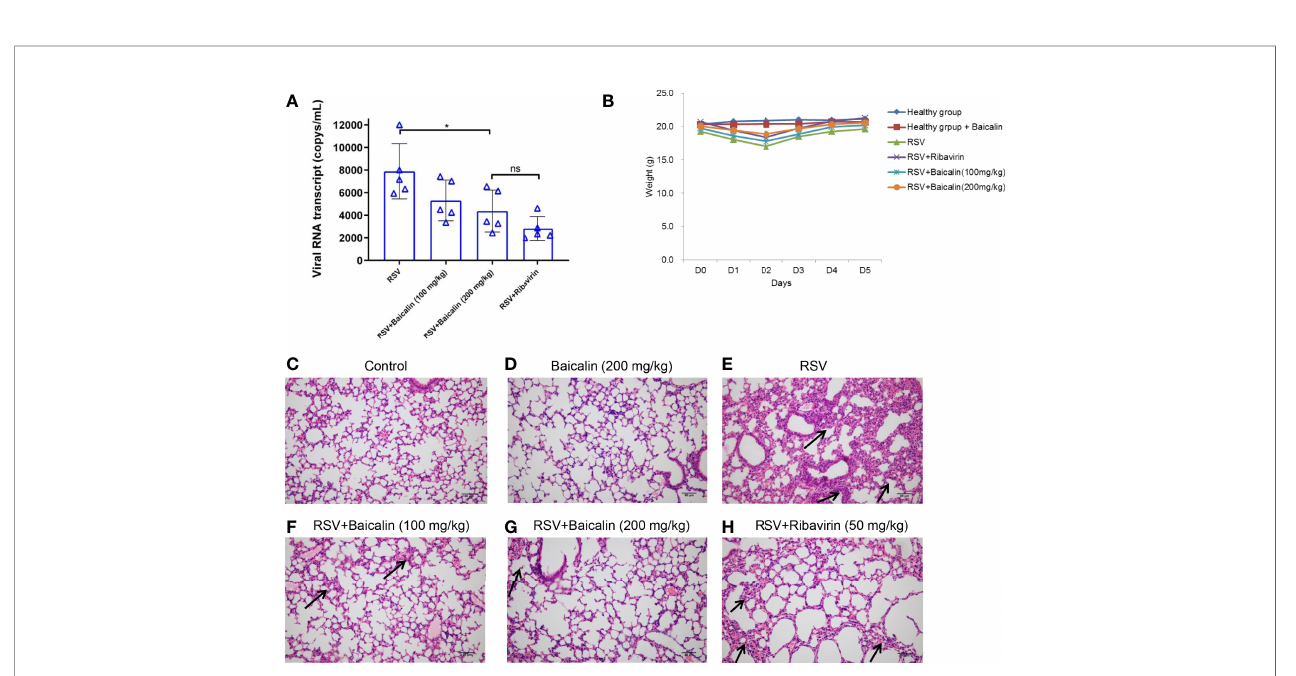
FIGURE 2 | Baicalin exhibits potent anti-RSV activity in vivo . (A) Expression of viral transcripts of RSV RNA was evaluated by RT-qPCR in lung homogenates obtained from RSV-infected mice, either untreated or treated with ribavirin or baicalin. Data is shown as mean ± SD (n = 5); * P < 0.05, ns , not signi fi cant – ANOVA with Tukey ’ s post-hoc test. (B) Weight of mice over fi ve days in the different experimental groups.No signi fi cant difference in weight was observed for any of the experimental groups. (C-H) Male BALB/c mice were infected with RSV on the fi rst day and were either left untreated (E) or treated with ribavirin (H) or increased concentrations of baicalin for fi ve days (F, G) . The presence of hyperplasia is indicated by the arrows. Healthy mice untreated (C) or treated with baicalin (D) were euthanized on day 5 and processed for H&E staining. Epithelial cell thickening observed in RSV-infected mice was ameliorated when treated with baicalin. Scale bar = 80